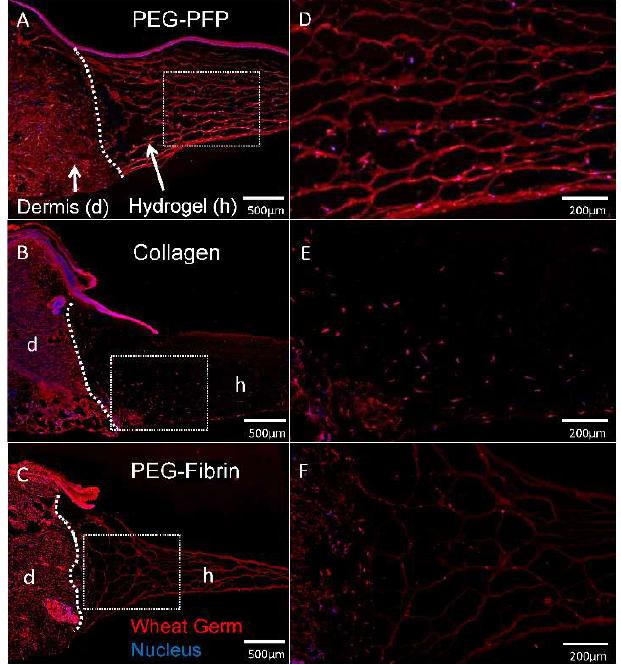
Figure 5. Immunofluorescence of epidermal stratification on day 14 explants treated with PEG-PFP. Top : CK-10 (green) stained the suprabasal layer of cells indicating formation of a stratified epidermis. Sections were counterstained with WG (red) to show the entire newly formed epidermis Nuclei (blue) are observed throughout the PEG-PFP hydrogel-treated area. The white dotted line represents the boundary from the normal dermis and the wound treated with PEG-PFP. Bottom : Enlarged view of white boxed region with a better visual representation of the stratified epidermis from the center of the wound.